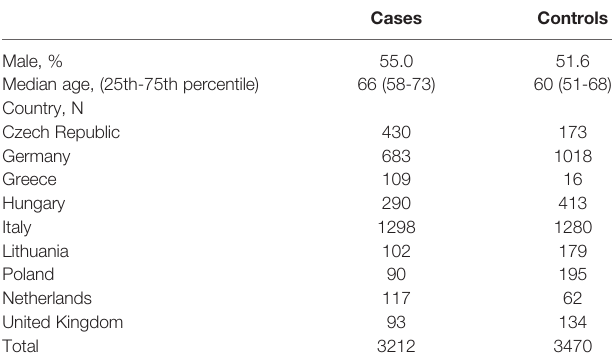
TABLE 1 | Characteristics of genotyped samples from PANDoRA after quality control.